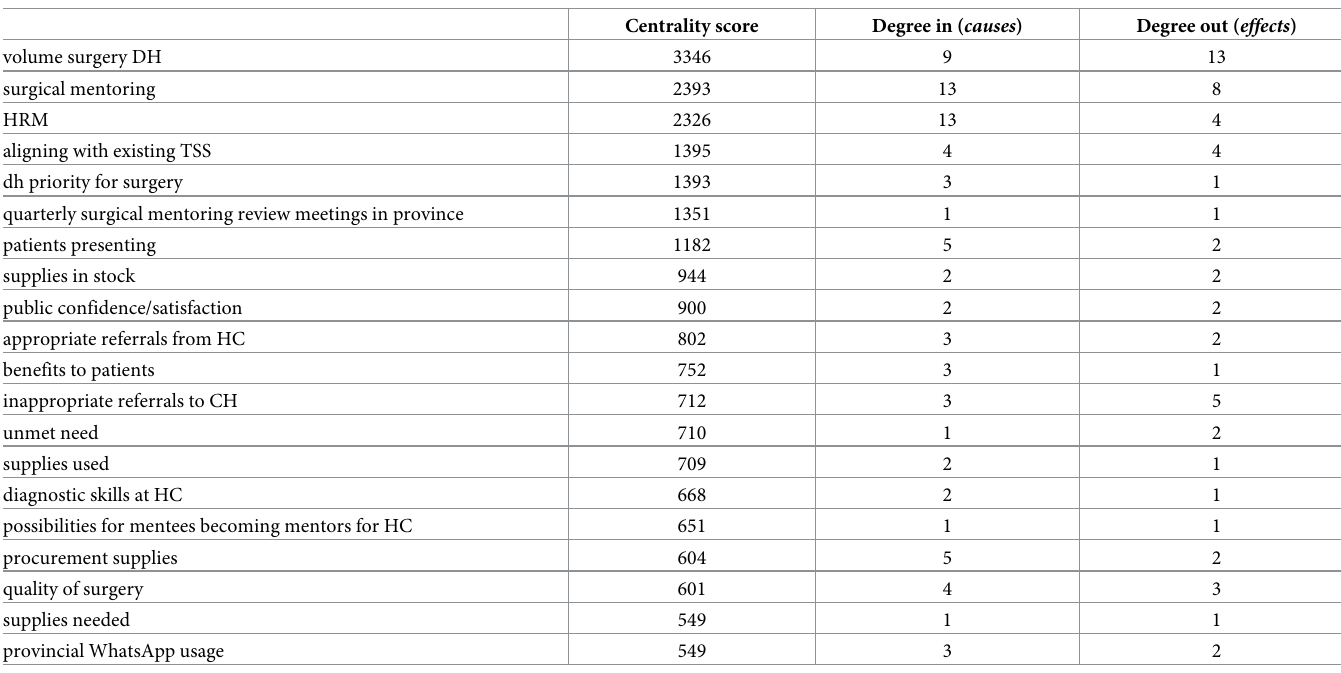
Table 3. Graph-theoretic metrics for the integrated causal loop